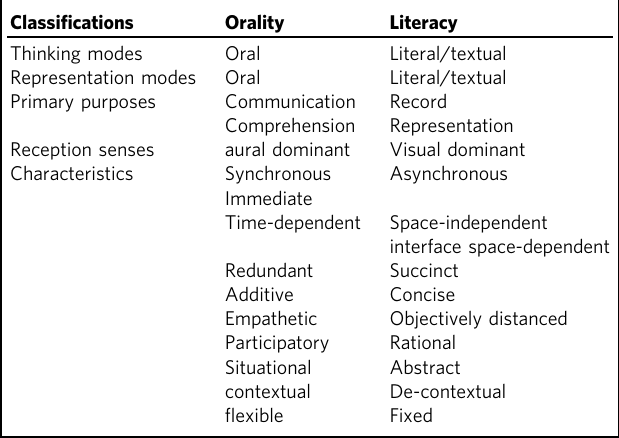
Table 1 Characteristics of orality and